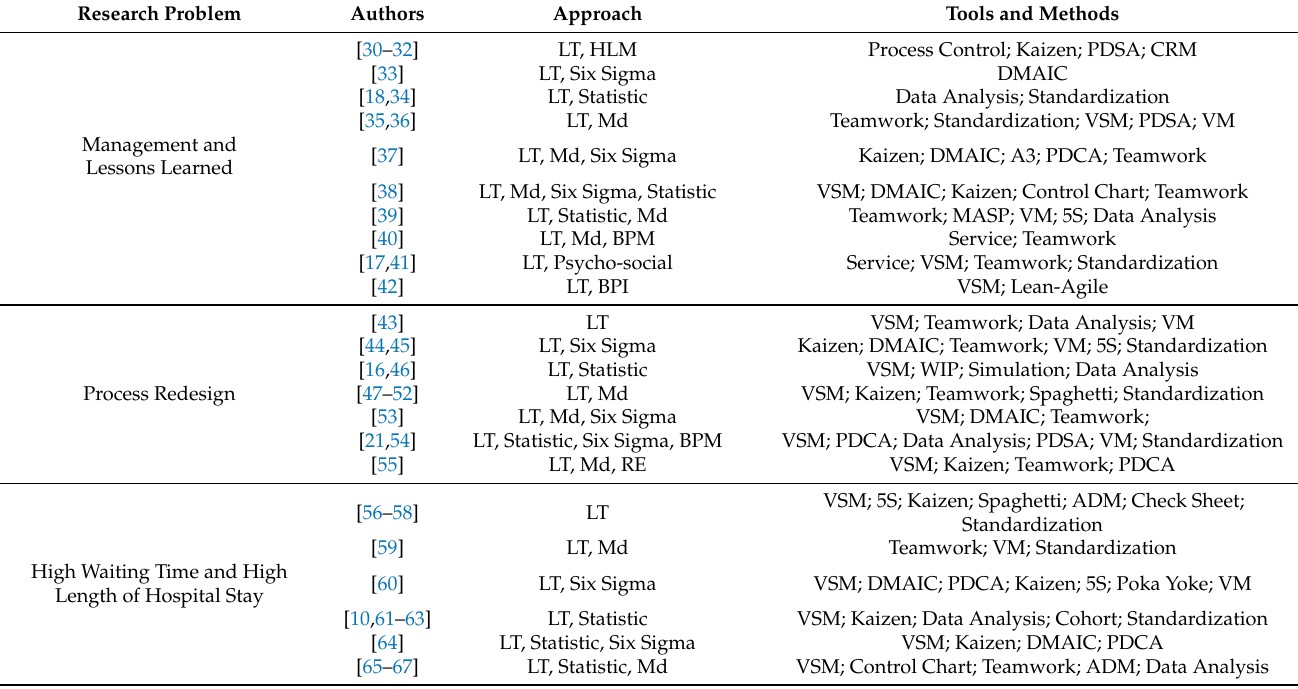
Table 2. Summary of research problems, approaches, and tools and methods by authors. Research Problem